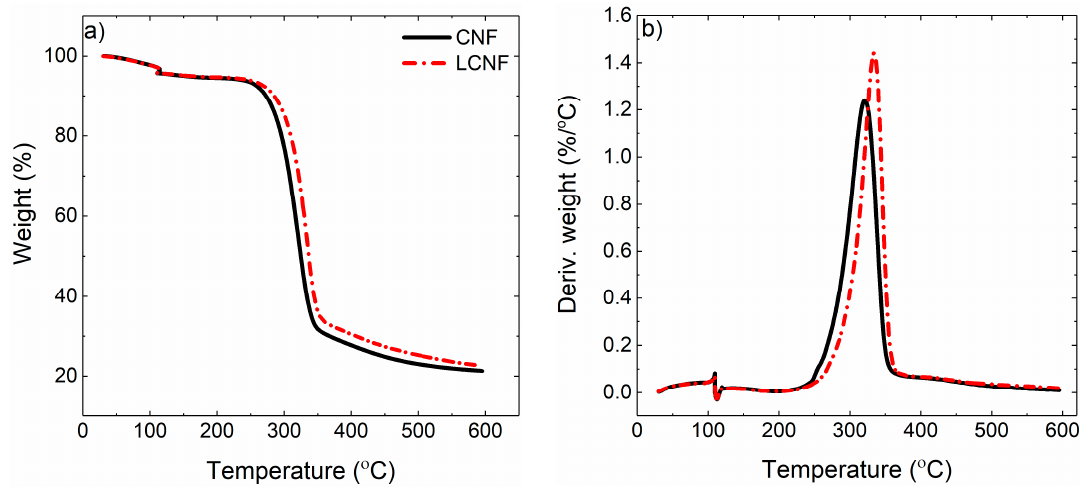
Figure 8. ( a ) Thermogravimetric analysis obtained from CNF and LCNF and ( b ) the corresponding derivative TG graphs .